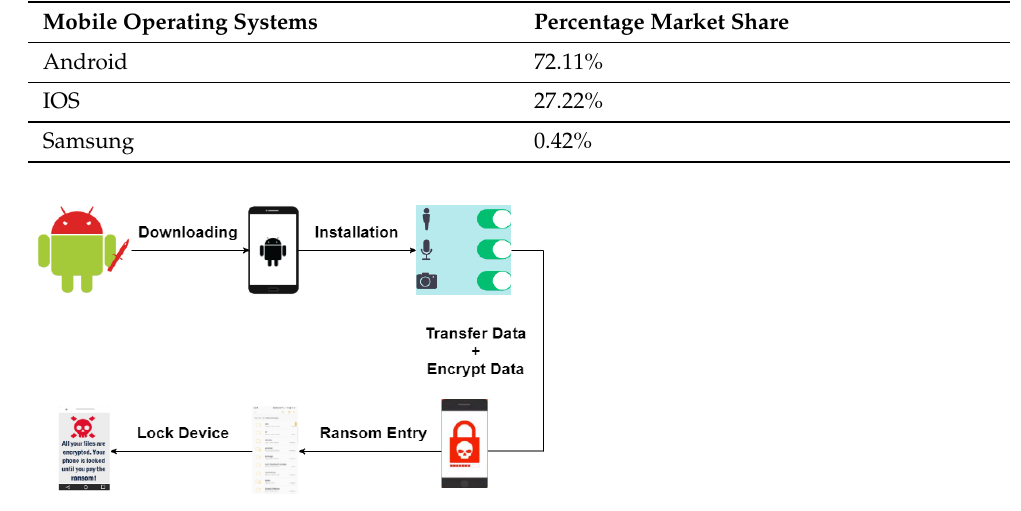
Figure 1. Android ransomware